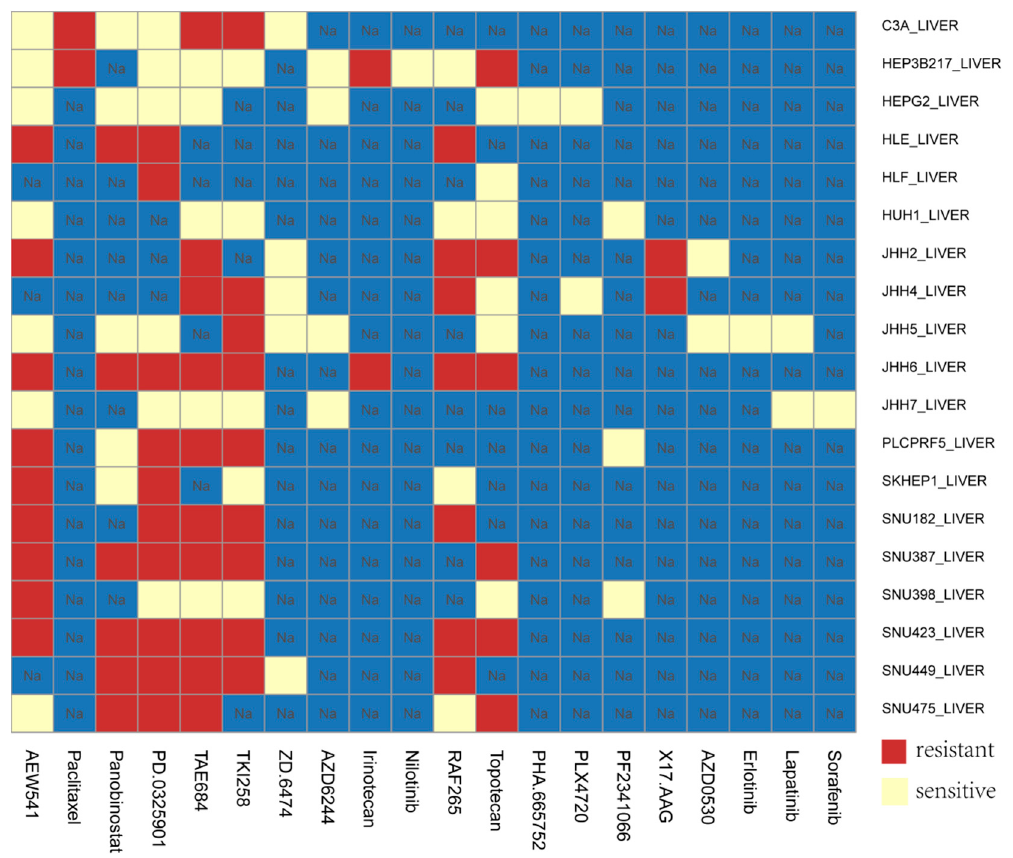
Figure 8. Application of prognostic risk score model in HCC cells.